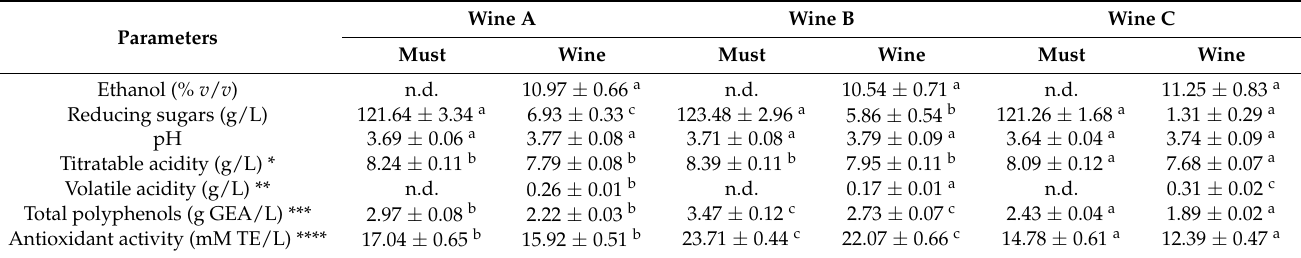
Table 2. Chemical characteristic of musts and cherry